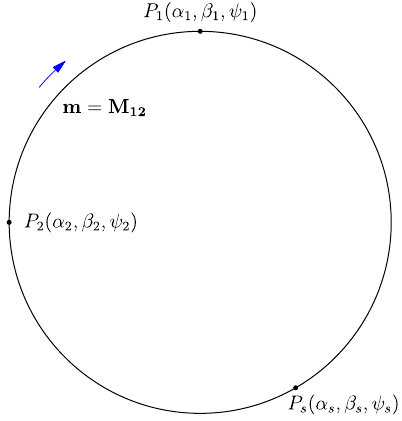
FIG. 2. Illustration of modulating the orbit with two correctors located at P 1 and P 2